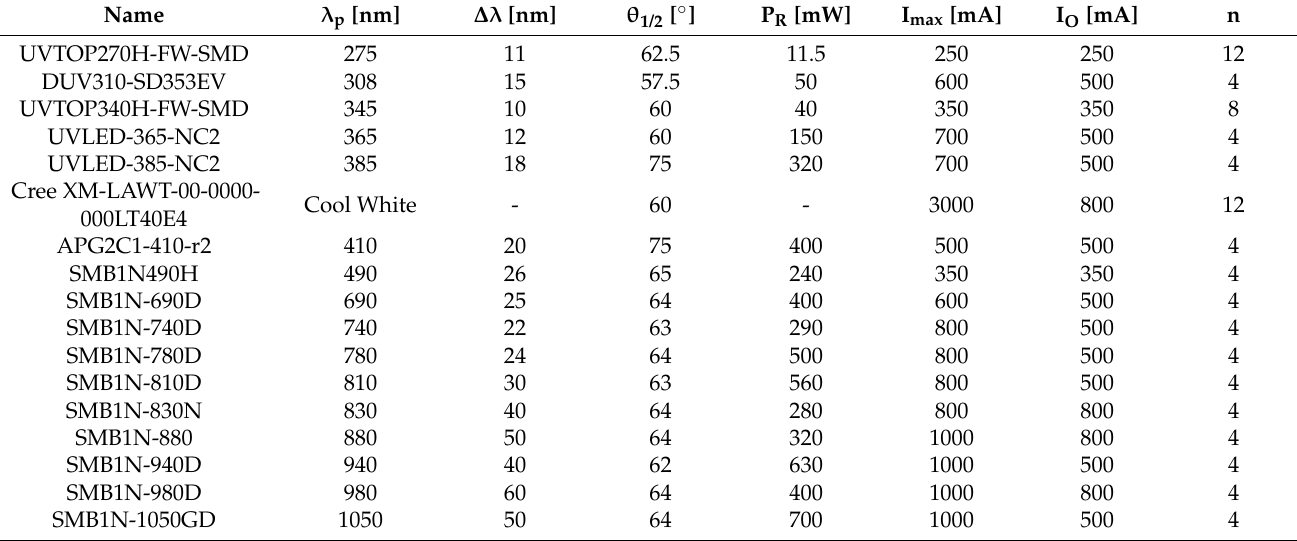
Table A1. Radiant power P R at max. current, max. current I max ; operational current I O , total number n of LEDs